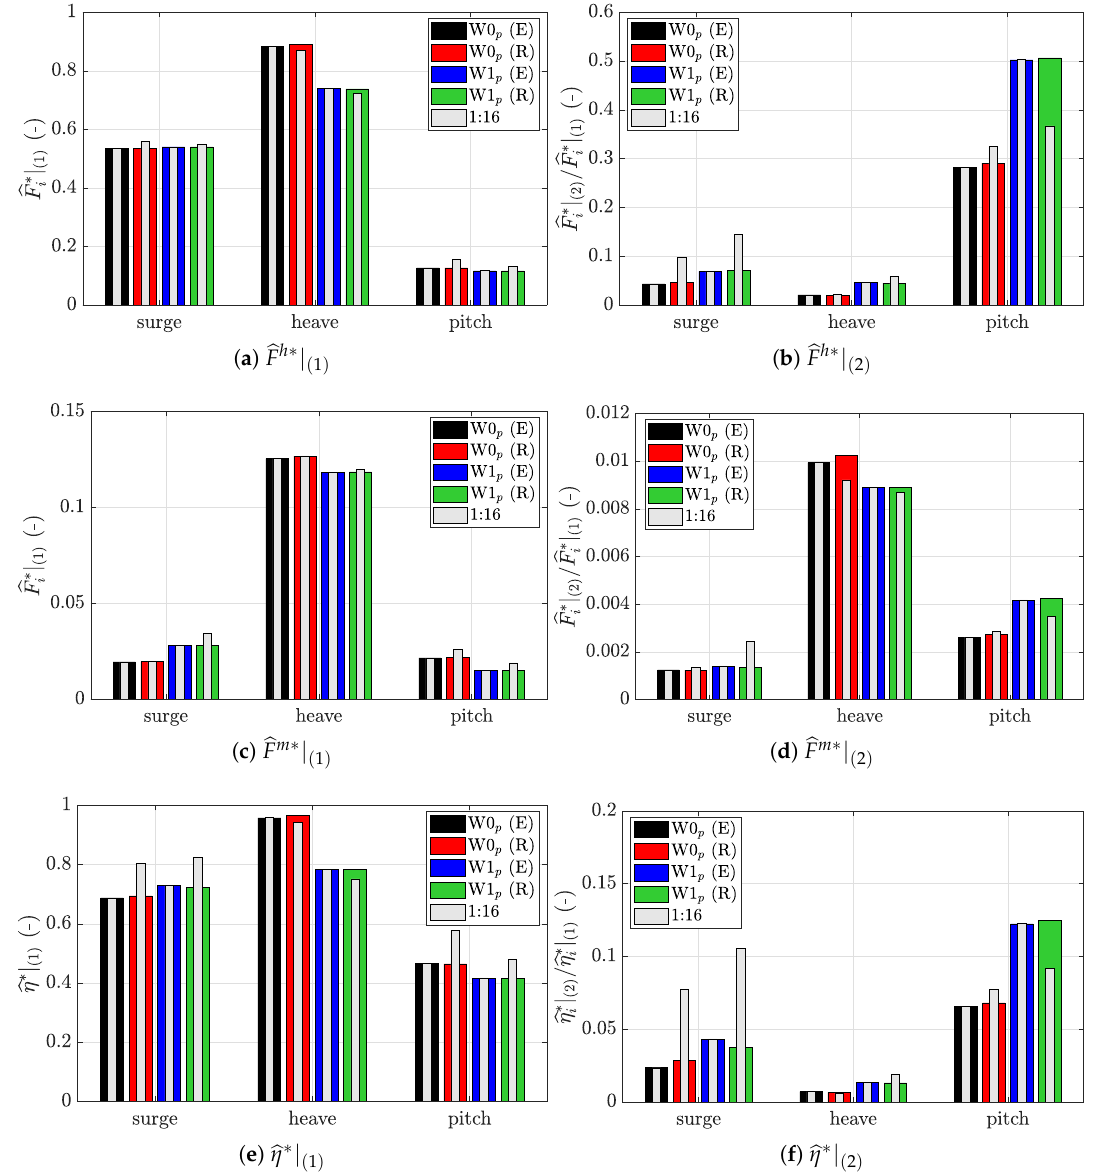
Figure 6. Euler (E) and RANS (R) results for the moored WEC in waves W0 and W1 showing first and second harmonic amplitudes in surge, heave and pitch. Top row shows hydrodynamic forces, middle row shows mooring forces and bottom row shows motion response. Left side is first order, and right side is second order. The coloured bars are prototype scale results, and the corresponding model scale (1:16) results are displayed as thinner grey bars. See Table 4 for non-dimensionalisation